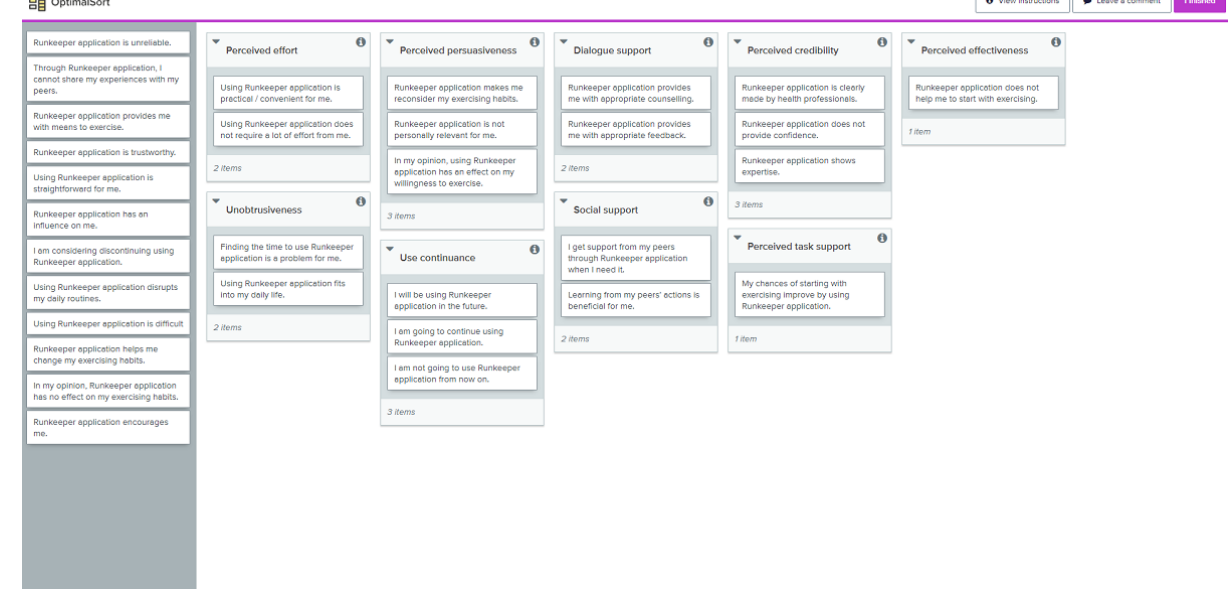
Figure 2. Screenshot of OptimalSort software during card sorting task.